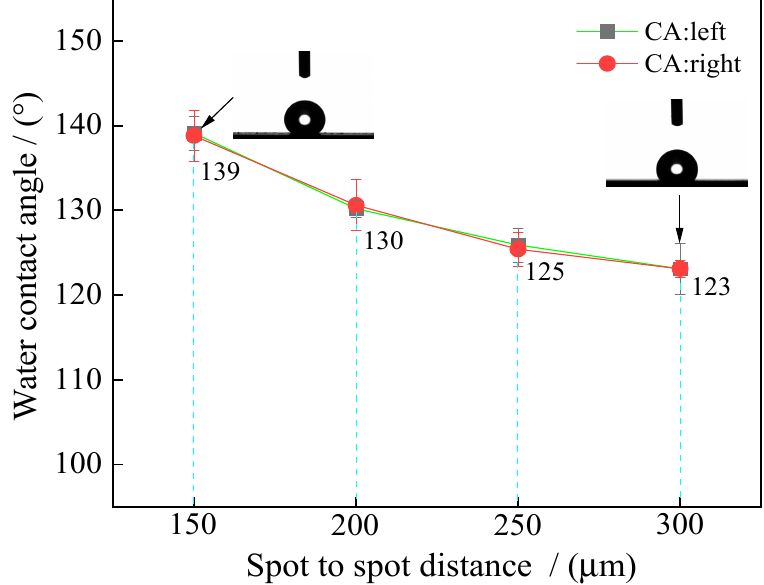
Figure 17. Effect of spot-to-spot distance on textured surface water contact angle.